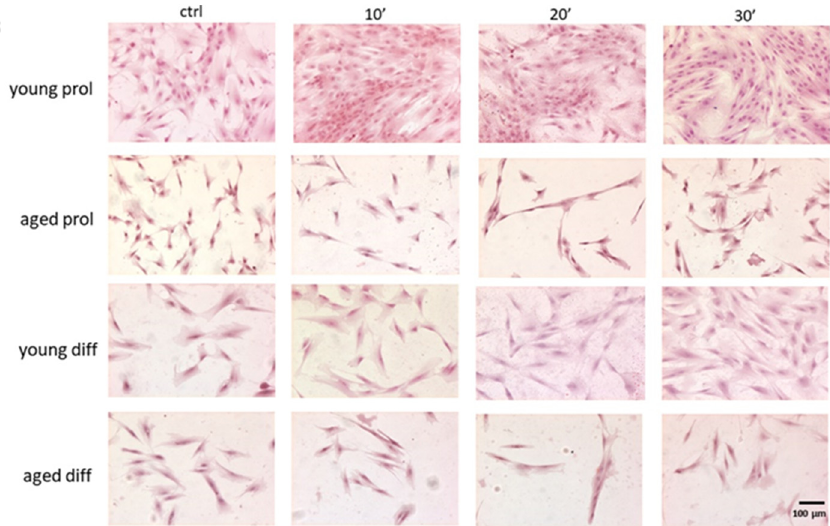
Figure 2. Effect of ViSS treatment on SC/myoblast size, density, and alignment. The cells typically showed an elongated morphology and the presence of one central nucleus and acidophilic cytoplasm. Representative fields of hematoxylin–eosin-stained samples.